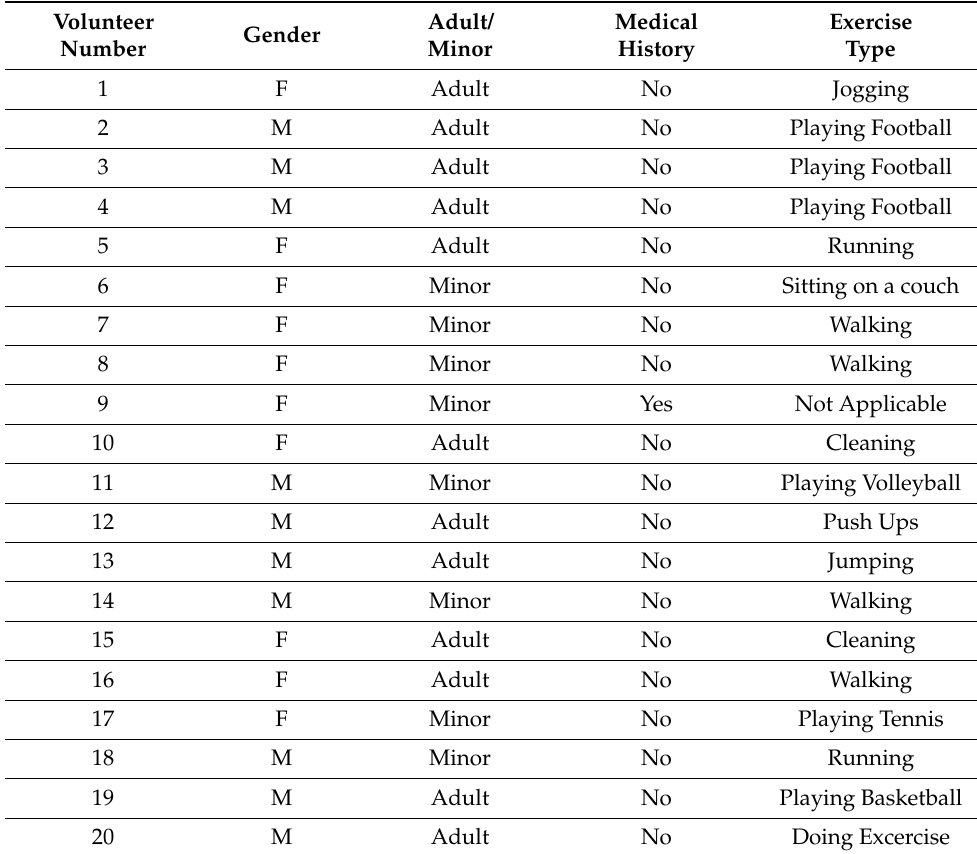
Table 1. Characteristics of volunteers.